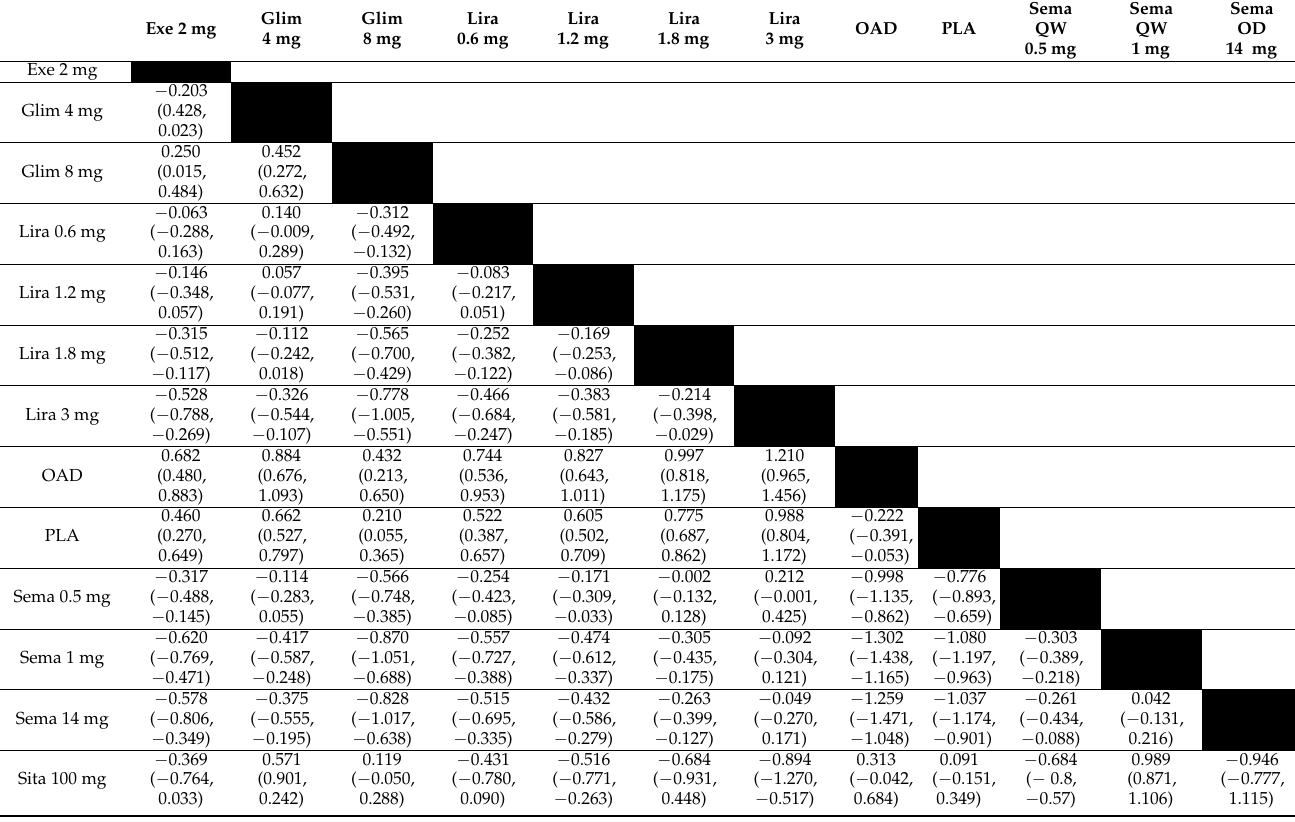
Table 3. NMA matrix for HbA1c change from baseline: treatment difference.